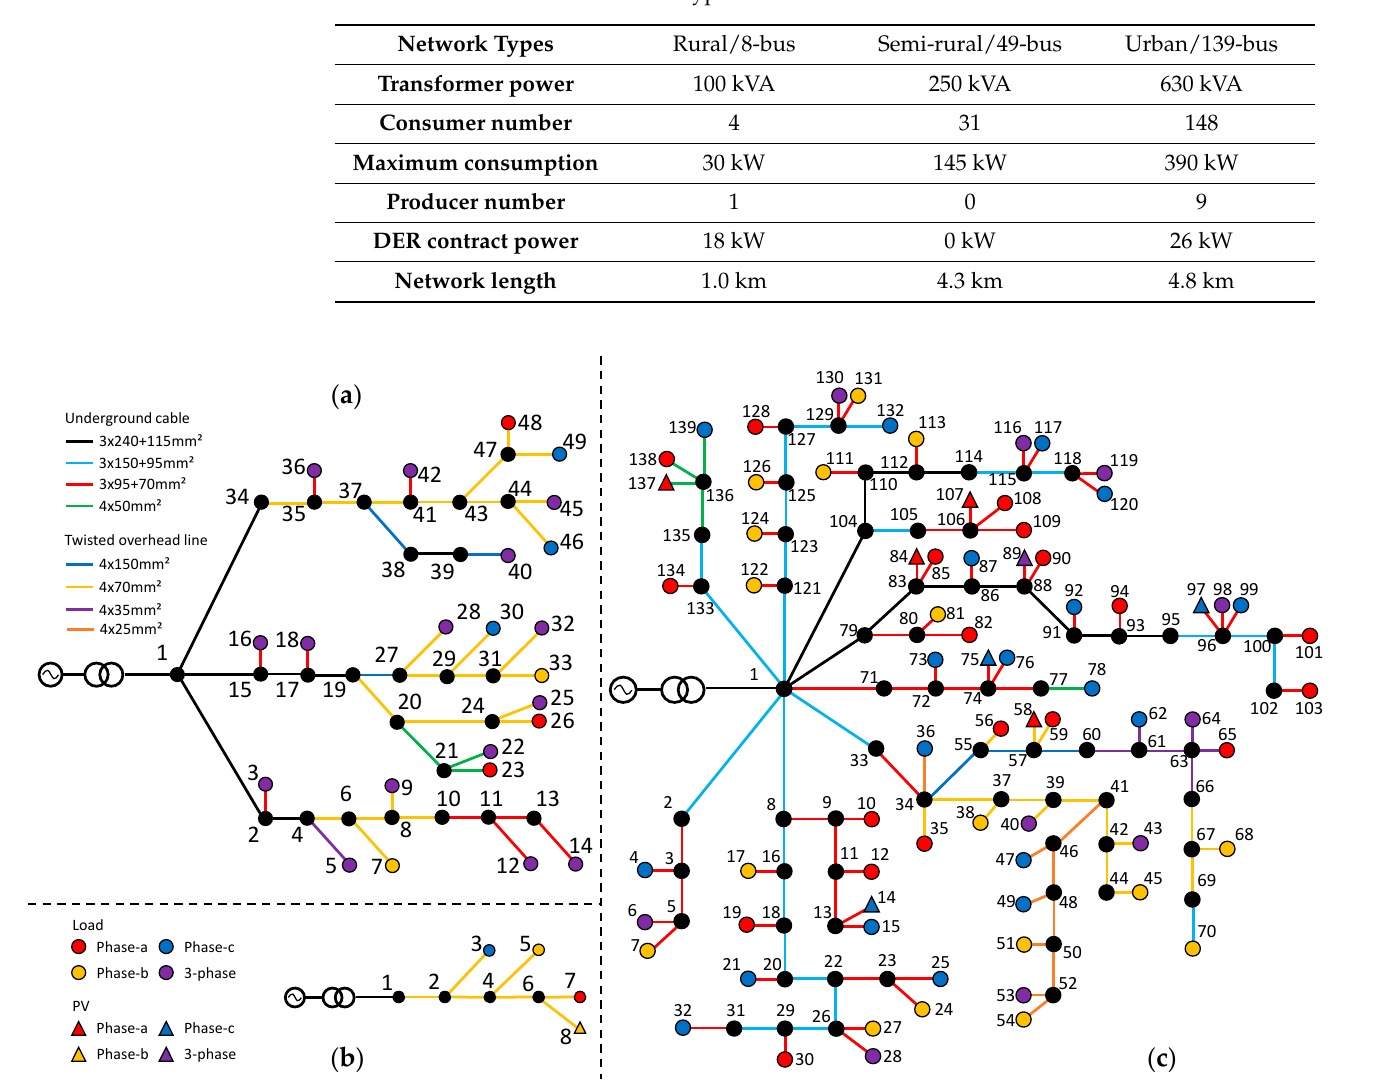
Figure 14. 49-bus ( a ), 8-bus ( b ) and 139-bus ( c ) networks with line type and load/PV connection phase. Rural, semi-rural and urban networks correspond to the 8-bus, 49-bus, and 139-bus, respectively. These networks are modified versions of the [34] networks. Table 9. Parameters of LV network types.